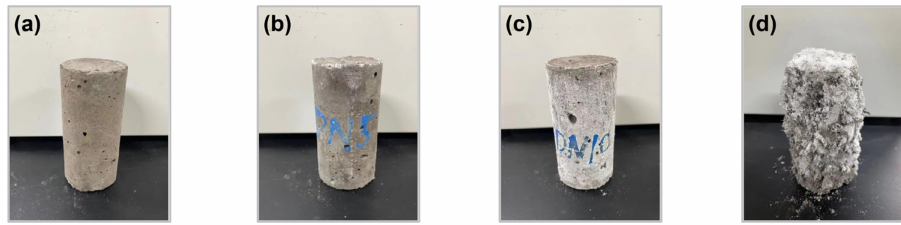
Figure 6. Crystalline precipitates of specimens formed after standing for 2 h at room temperature in solutions of different concentrations: ( a ) DN0; ( b ) DN5; ( c ) DN10. The crystalline precipitation of the specimens occurred during storage at the end of the experiment: ( d )